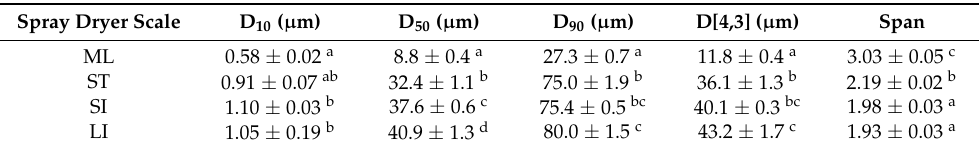
Table 1. Particle size distribution (mean ± standard deviation of five replications of D 10 , D 50 , D 90 , and D[4,3], span) of spray dried beetroot